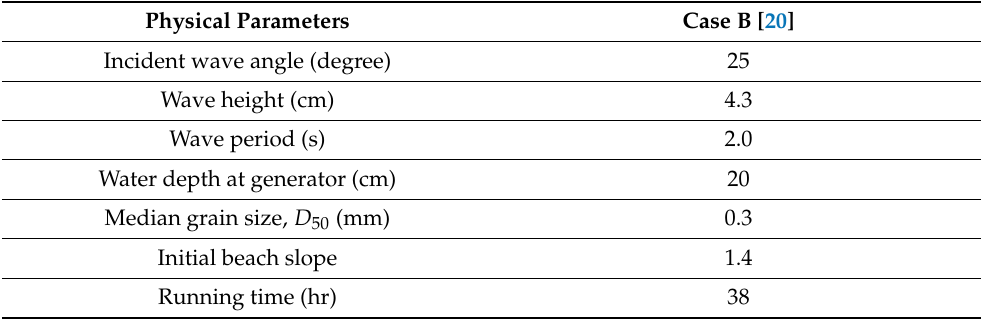
Table 1. The physical parameters of Case 1.